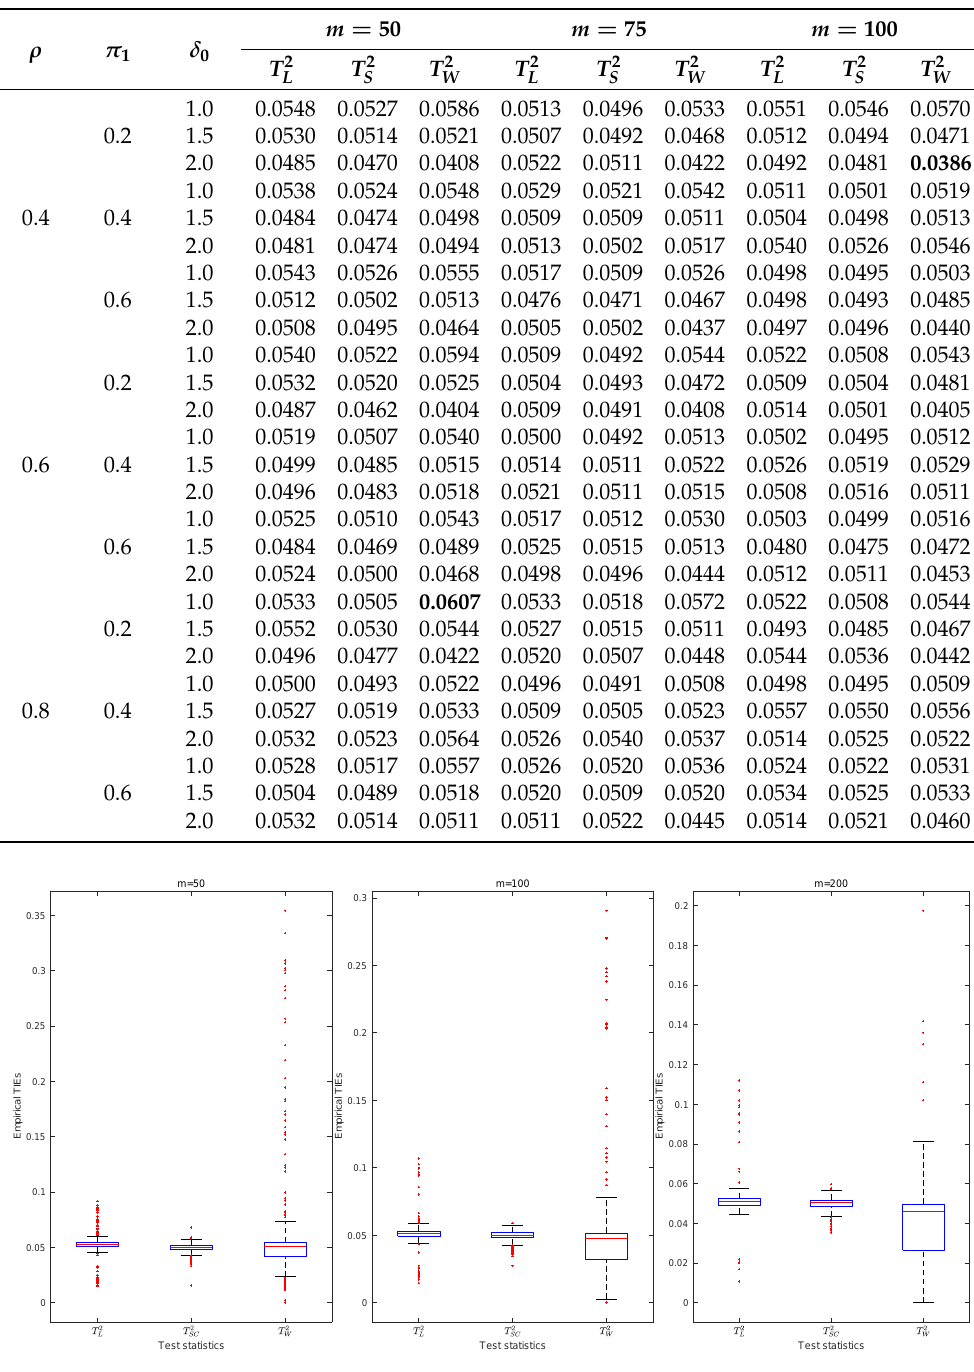
Figure 1. Boxplots of empirical TIEs for 1000 parameter